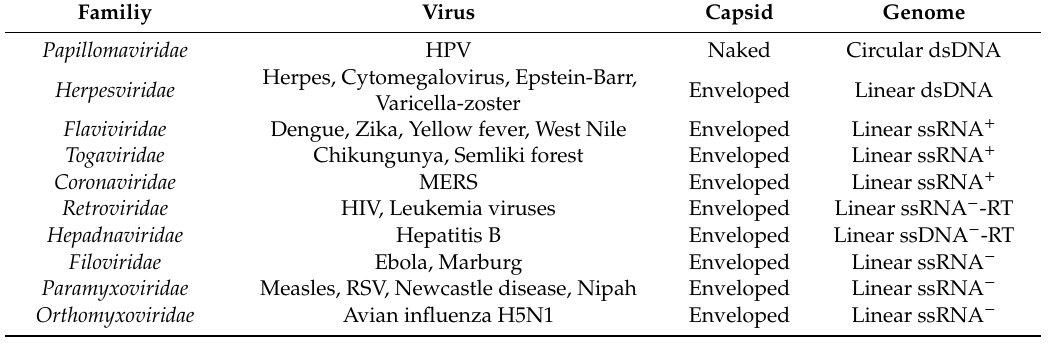
Table 1. Families of pathogenic viruses that are PC dependent. Many families of viruses exploit the host-cell PCs to regulate their cell entry mechanism.